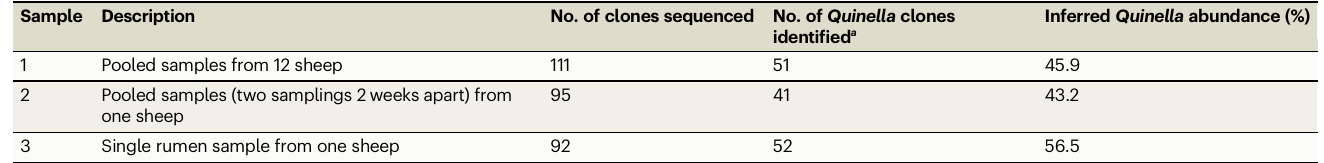
Table 1 | 16S rRNA gene clone libraries prepared from Quinella -enriched samples Sample